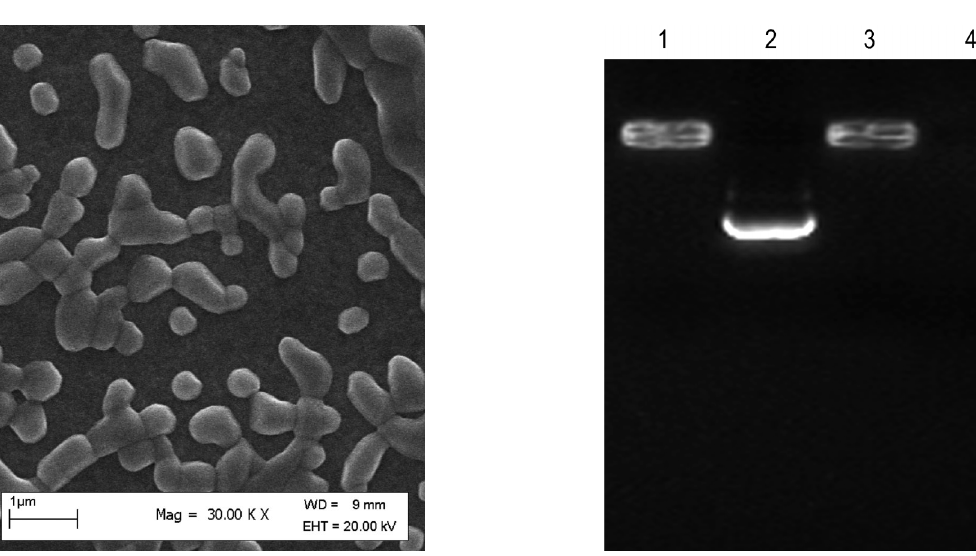
Figure 1. Scanning electron microscope (SEM) analysis of the chitosan-encapsulated plasmid DNA. DNA plasmids were encapsulated by the chitosan at the ratio of 1:7, and the generated chitosan-DNA complexes were observed under the SEM at a magnification of 30,000 6 .